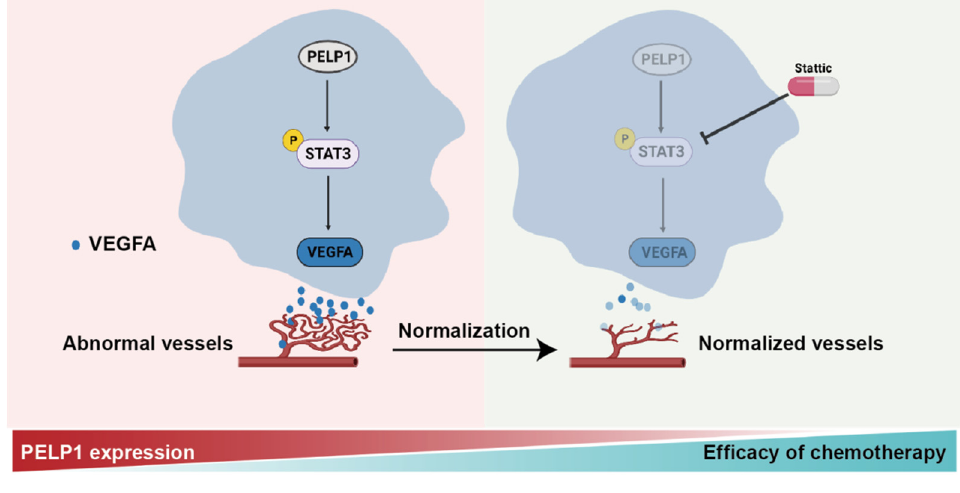
Figure 7. PELP1 regulates the expression of VEGFA by the STAT3 to promote tumor angiogenesis in CRC. Further, PELP1 suppression could enhance the efficacy of chemotherapy, which is caused by the normalization of vessels.